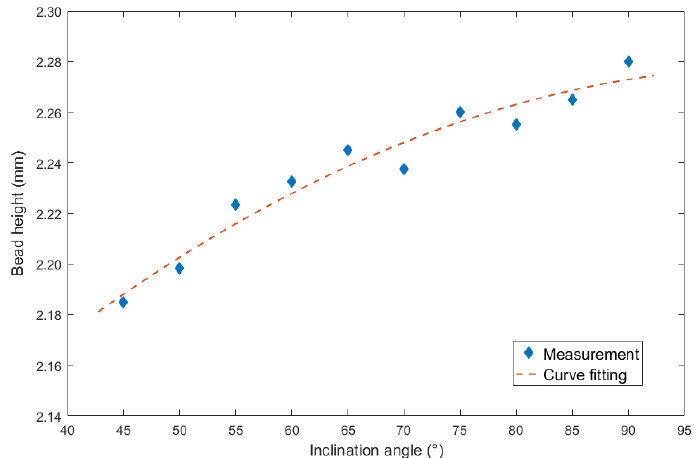
Figure 10. Curve fitting between backward inclination angle and bead height.